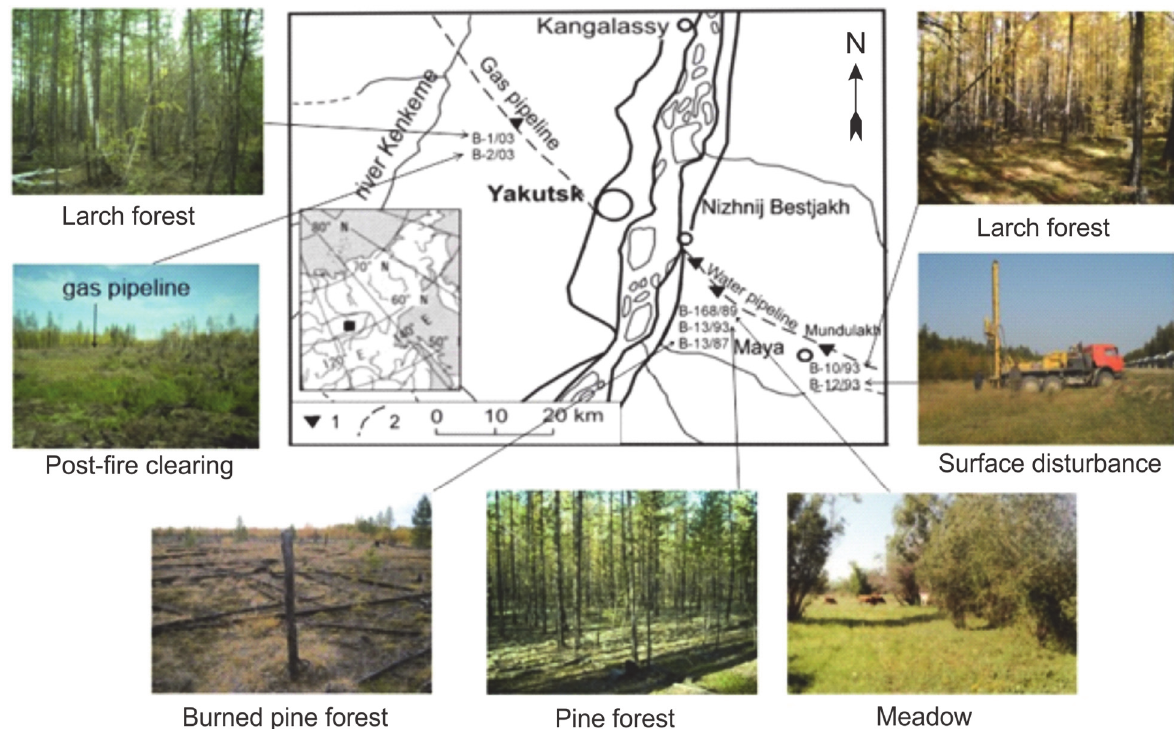
Figure 1. Map and photos of the study area showing monitoring sites and pipelines.